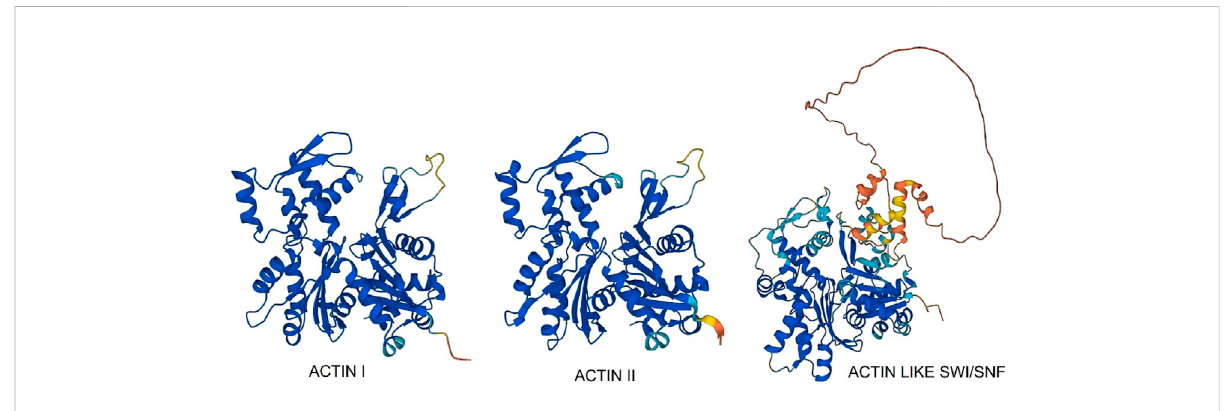
FIGURE 7 AlphaFold models of three P. falciparum actins found bound to